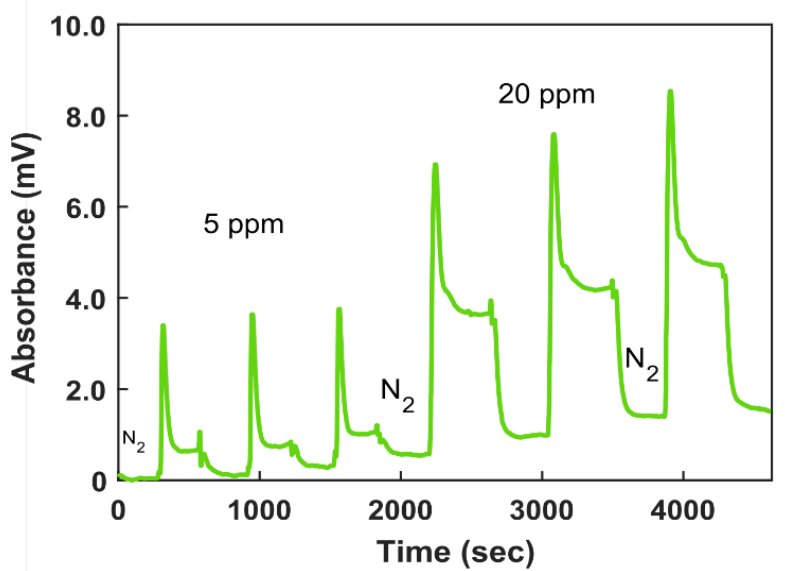
Figure 5. Absorbance signal in milli-volts recorded for the toluene-N 2 mixture of 5 ppm and 20 ppm. Pure nitrogen was injected in-between the different gaseous toluene injections.